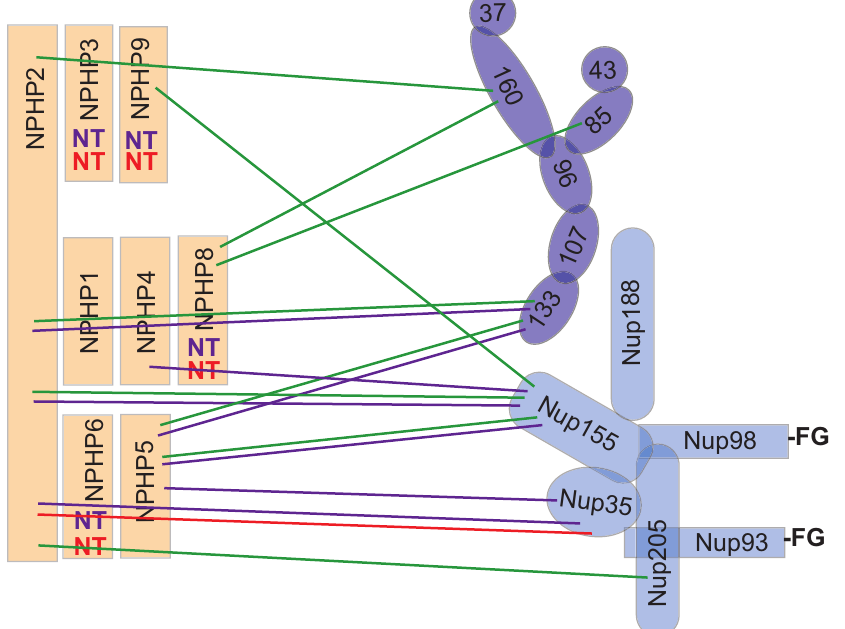
Fig 6. Summary of NPHP-NUP interactions. Components of the inner ring nucleoporin (medium blue), outer ring nucleoporin (dark blue), and NPHP (orange) complexes are indicated. Green lines indicate interactions detected in the directed yeast two-hybrid assay (strong and medium only). Purple lines indicate interactions detected in the knocksideways assays. The red line indicates the spatial proximity relationship observed in the BiFC assay. FG, Phenylalanine-Glycine repeats. NT, not